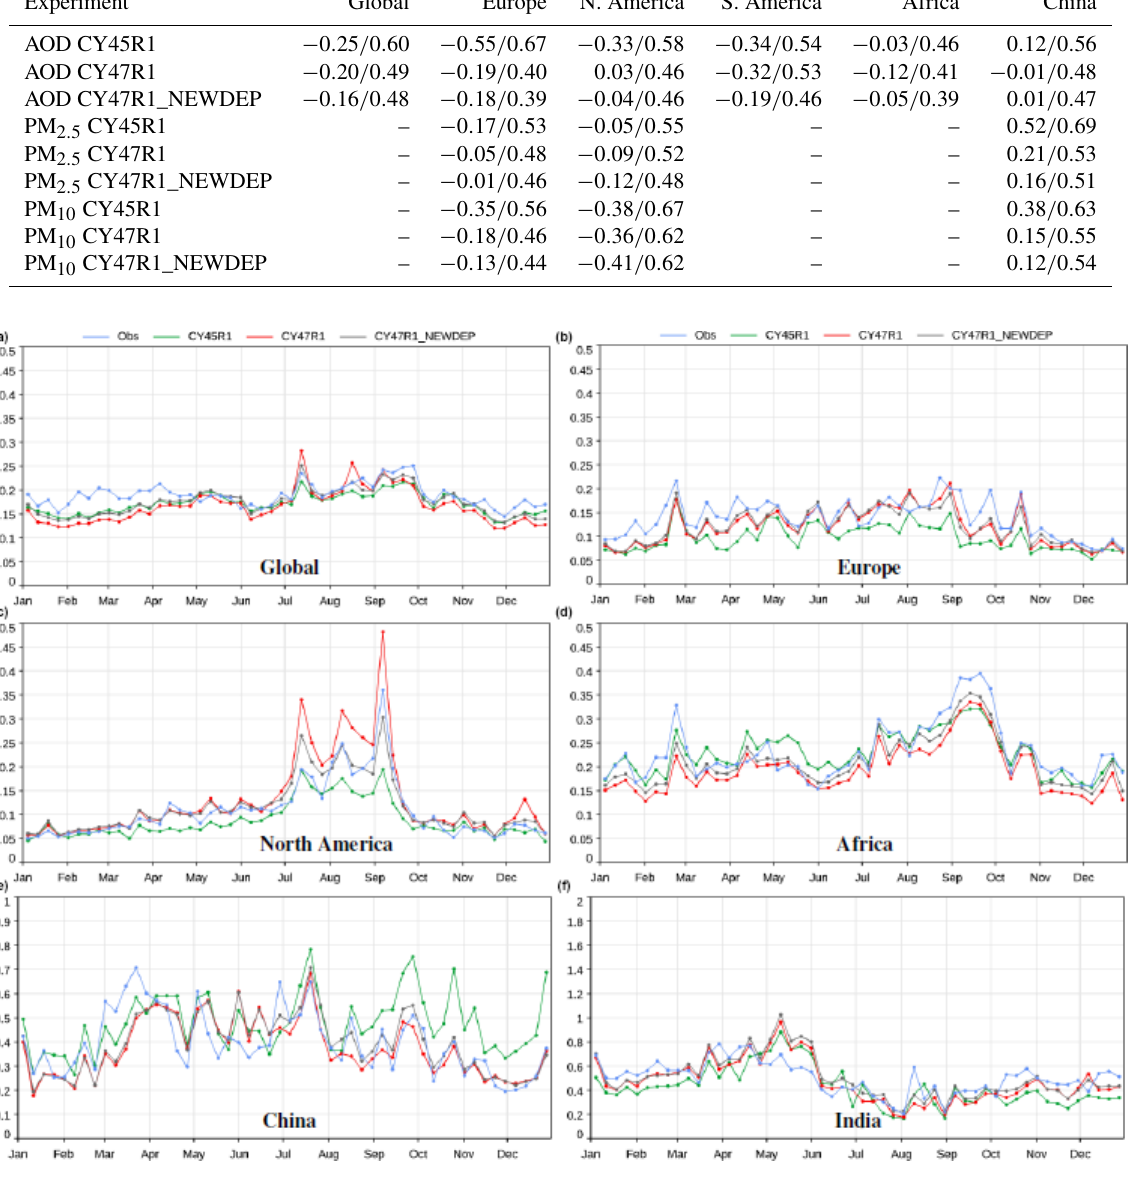
nitrogen oxides are highest, i.e. over India and China. Some secondary maxima also appear over seasonal biomass burn-